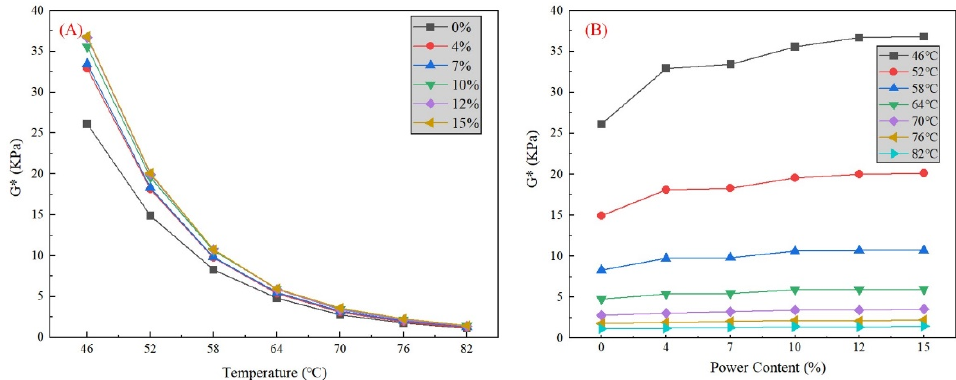
Figure 8. Variation of composite shear modulus G* with different ( A ) test temperature, and ( B ) mineral powder content.